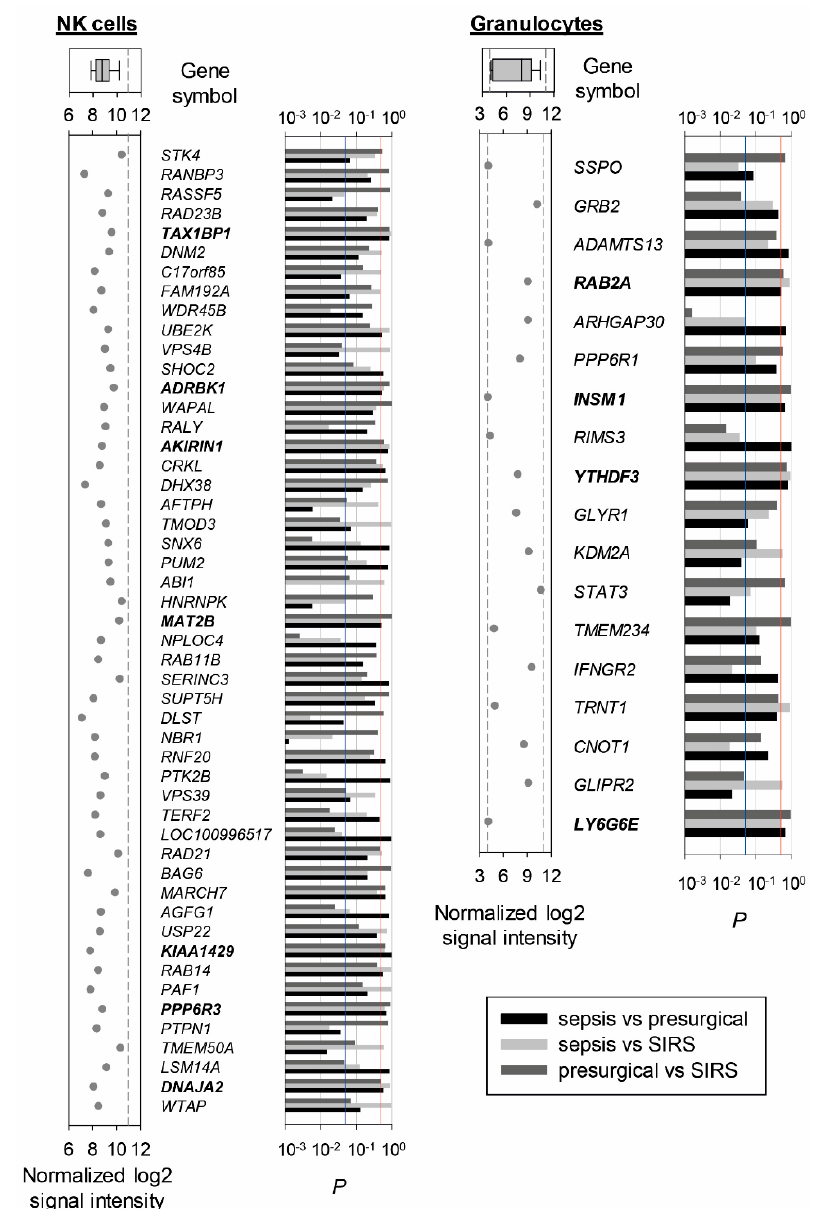
Figure 1. Discovery of candidate reference genes from microarray data of NK cells and granulocytes from presurgical, SIRS, and sepsis patients (discovery set). Genes without significant di ff erence in abundance from one-way analysis of variance with false discovery rate correction ( α > 0.05) and with intermediate normalized log 2 signal intensity values were selected. They were ordered from top to bottom by decreasing variability across all 45 NK cell samples (19 presurgical, 16 SIRS, and 10 sepsis), of which the top 50 are shown on the left, and all 42 granulocyte samples (11 presurgical, 16 SIRS, and 15 sepsis) for which only the 18 genes shown on the right met the selection criteria. To the left of the gene symbols, normalized log 2 signal intensities from the microarrays are given with dashed lines indicating the cuto ff intensities from our selection criteria. On top, corresponding box plots with whiskers from 5 th to 95 th percentile and median are plotted. The bars to the right represent p -values from unadjusted t -tests for the corresponding three pairwise patient group comparisons. The blue line marks the significance threshold of p = 0.05, and the red line marks the threshold of p = 0.5 for selecting genes with putatively highly similar abundance among the three groups. Genes with above- or borderline-threshold p -values for all three comparisons are printed in bold.